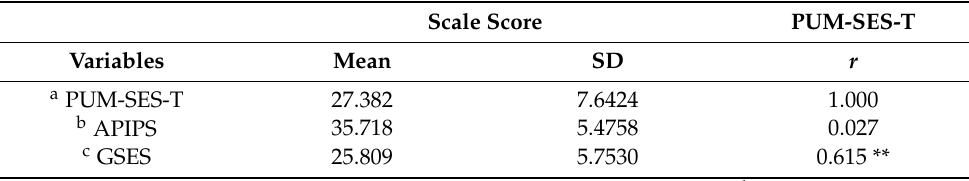
Table 2. Pearson correlation and mean score of PUM-SES-T, APIPS, and GSES. Scale Score PUM-SES-T Variables Mean SD r a